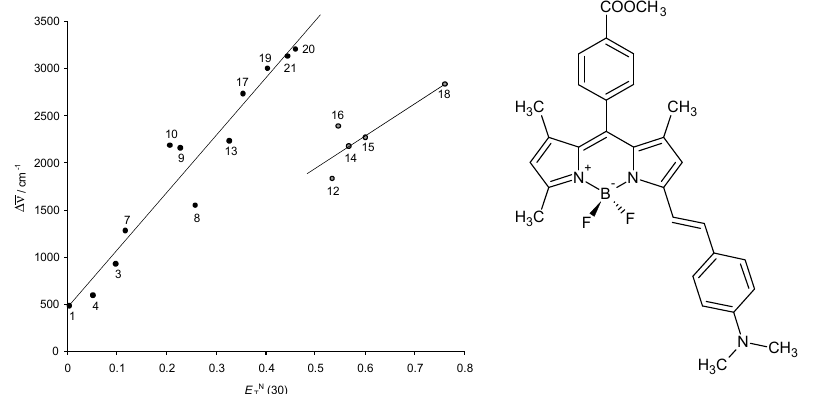
Figure 18. The dependence of the Stokes shift ( ∆ ν ) on the solvent polarity parameter E N T (30) for IX . The numbers 12, 14, 15, 16, and 18 correspond to the protic solvents, and all other numbers correspond to the aprotic ones. Ref. [84]—Adapted by permission of The Royal Society of Chemistry (RSC) on behalf of the European Society for Photobiology, the European Photochemistry Association, and RSC.